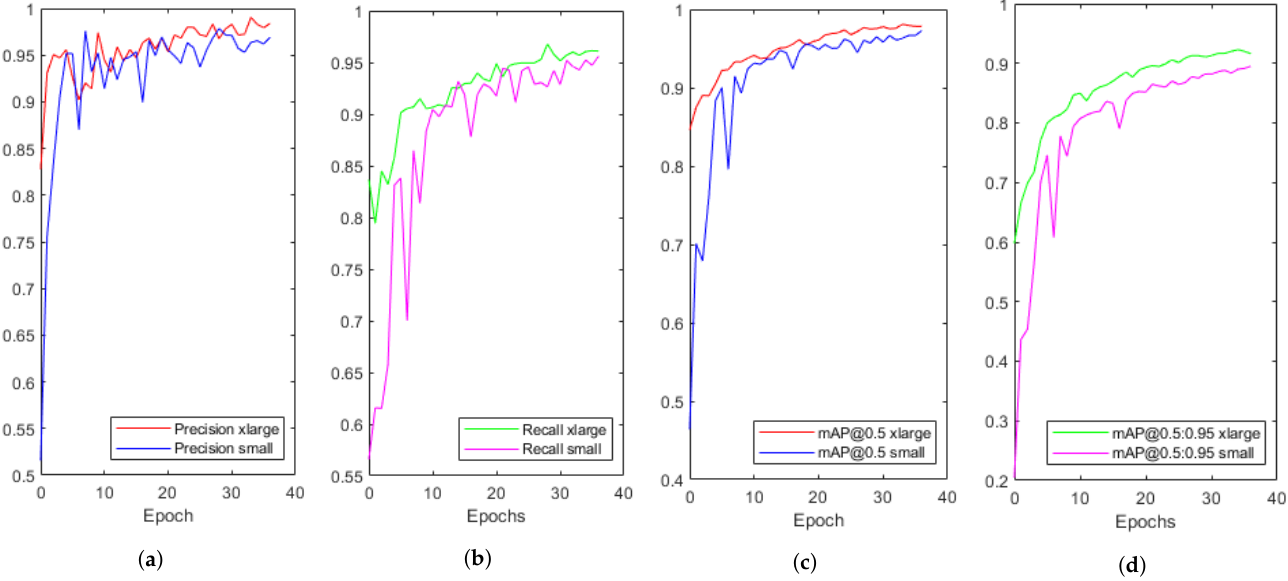
Figure 13. Comparison of training results between the small and xlarge models. ( a ) precision; ( b ) recall; ( c ) mAP over 0.5; ( d ) gradual mAP 0.5:0.05:0.95. The small model had a size of 14 MB and the xlarge a size of 689 MB, which made the xlarge model almost 50 times larger than the small model. Additionally, the small model had an inference time of 4.1 ms and the xlarge model 15.2 ms, which made the small model almost four times faster than the xlarge model in computation time. Table 1 shows the differences between the models as